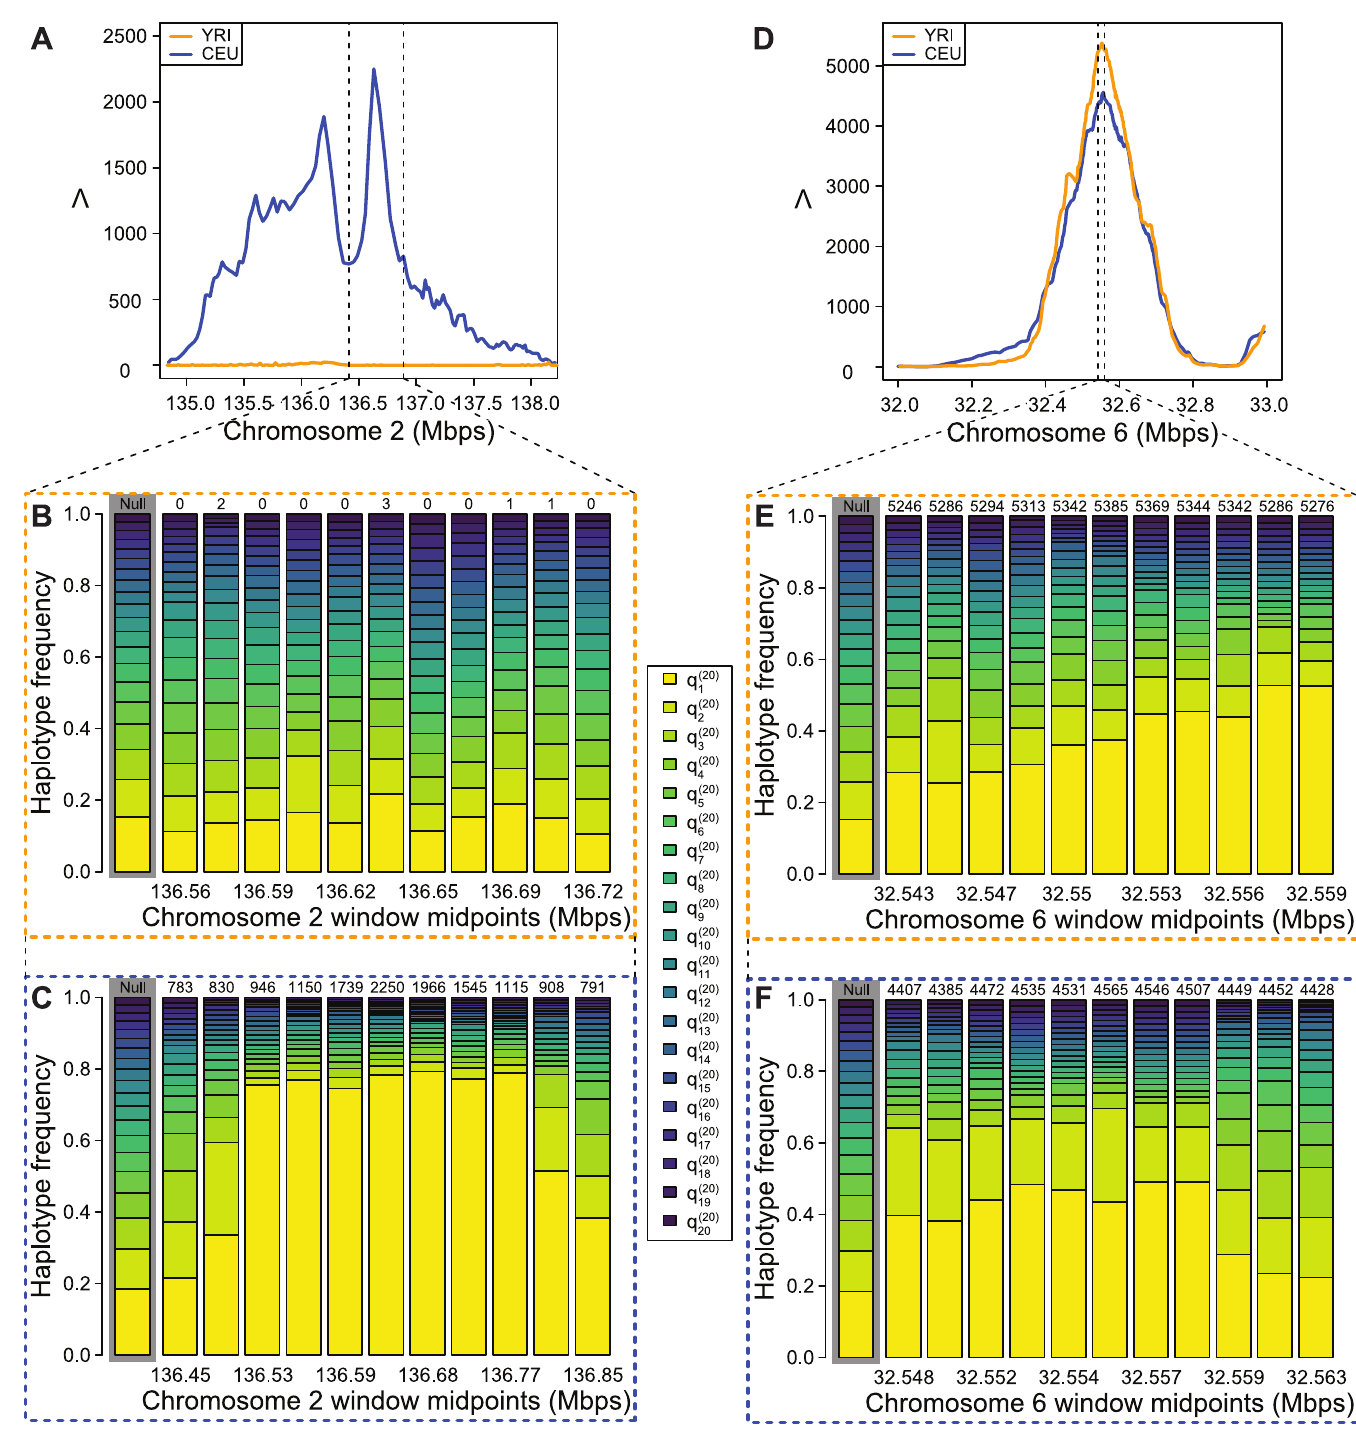
Fig 6. Detailed illustration of Λ statistics and haplotype frequency spectra in CEU and YRI. (A) Λ plotted in the LCT region, vertical dotted lines indicate zoomed region shown in (B) and (C). (B) YRI empirical HFS for 11 windows in the LCT region. (C) CEU empirical HFS for 11 windows in the LCT region. (D) Λ plotted in the MHC region, vertical dotted lines indicate zoomed region shown in (E) and (F). (E) YRI empirical HFS for 11 windows in the MHC region. (F) CEU empirical HFS for 11 windows in the MHC region. In (B), (C), (E), and (F), numbers above HFS are Λ values for the window rounded to the nearest whole number, and the genome-wide average HFS is highlighted in grey. q 20 is the frequency of the i th most common haplotype truncated to K = 20. i